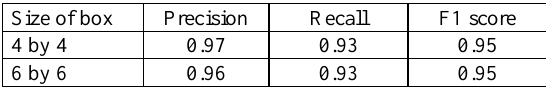
Table 2 . France data set results.